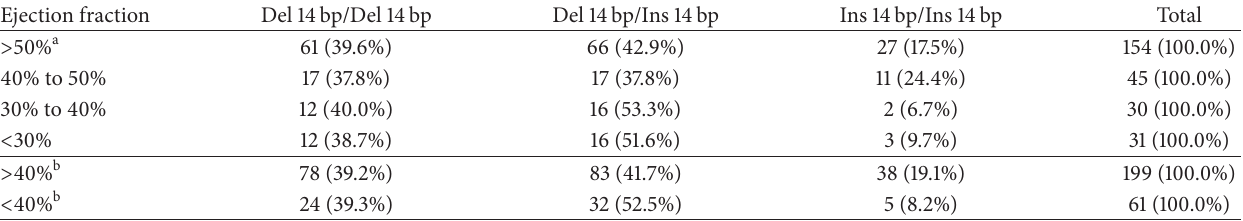
Table 3: Distribution of genotypes of the 14bp insertion/deletion polymorphism in the 3 󸀠 -untranslated region of the HLA-G gene in relation to left ventricular ejection fraction.